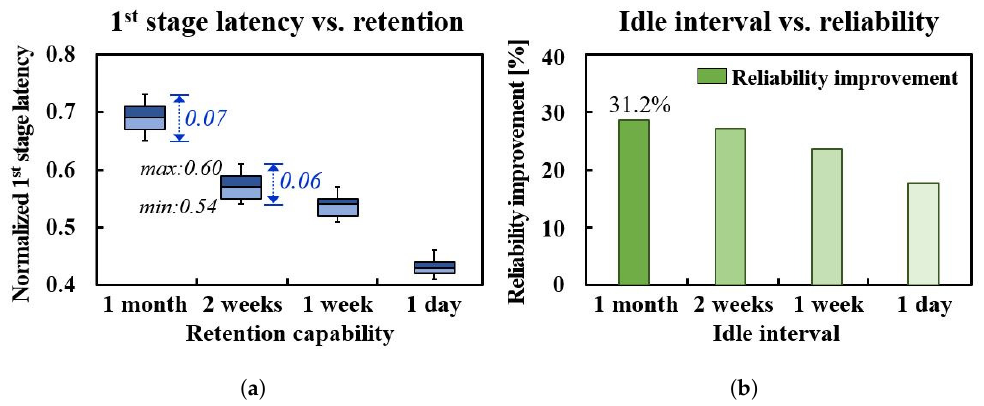
Figure 5. Changes in retention capability and stage_t latency. ( a ) Stage_t latency vs. retention. ( b ) Idle interval vs.